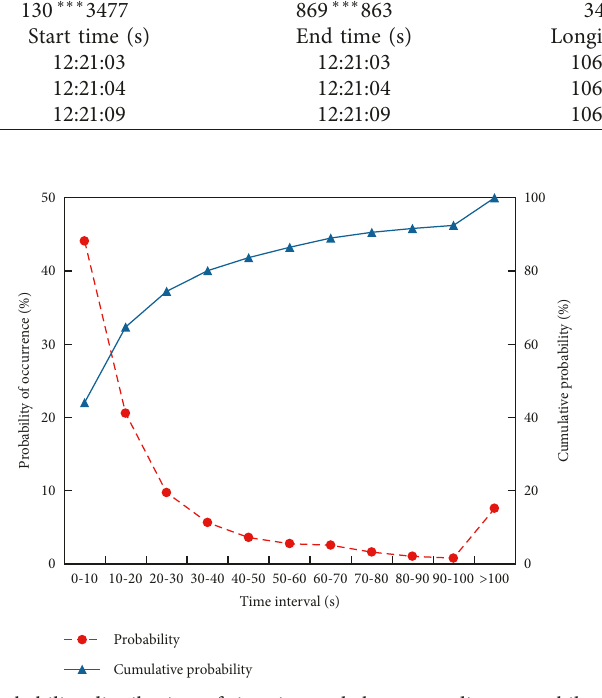
Figure 9: Probability distribution of time intervals between adjacent mobile phone data.